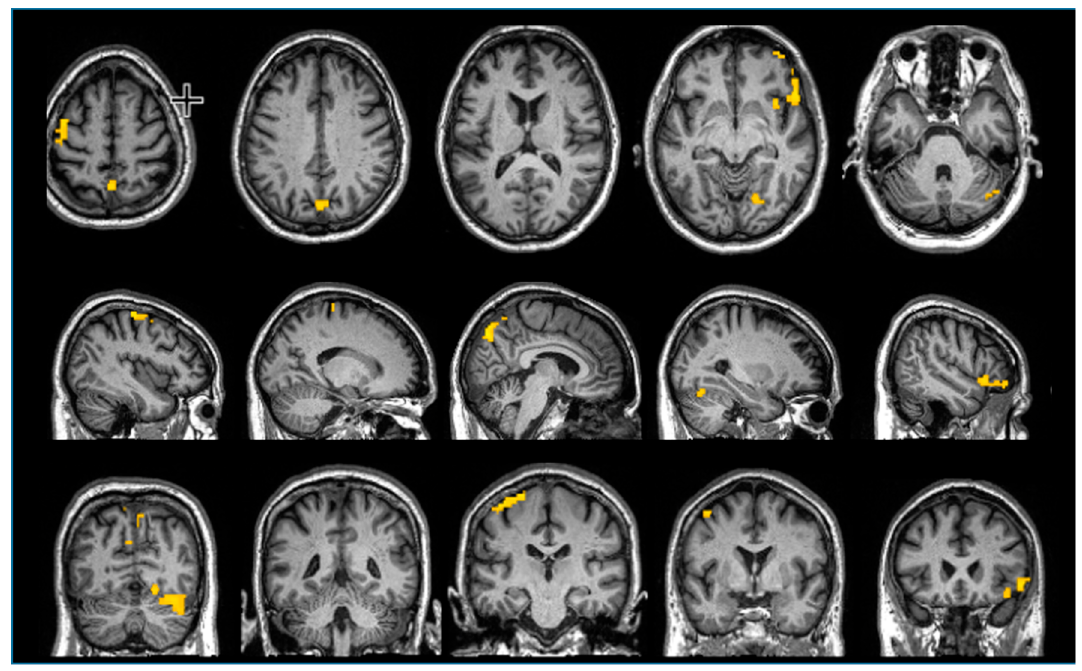
Figure 2. Functional magnetic resonance imaging (fMRI) of the patient with pneumatic finger vibration on the right thumb and index finger. Blood oxygenation level dependent (BOLD) response is seen contralaterally within the primary sensorimotor cortex SM1, within the right cerebellar hemisphere, bilaterally within the posterior parietal somatosensory cortex, and within the insular and inferior frontal cortex of the right hemisphere.